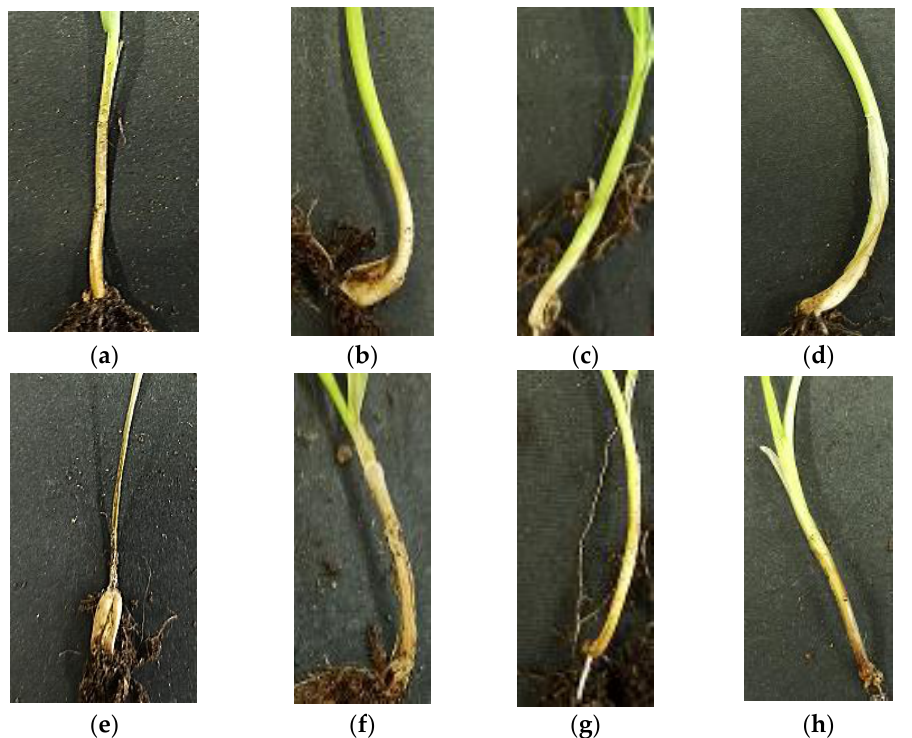
Figure 4. Effect of Trichoderma harzianum T-22 at 21 days after sowing, on the reduction in Fusarium crown rot symptoms in the seedling coleoptiles of four Italian tetraploid durum wheats derived from wheat seed treated with T-22 and sown in a substrate with F. culmorum ( a – d ) or left untreated ( e – h ): Ciclope ( a , e ), Creso ( b , f ), Simeto ( c , g ), and Saragolle Lucana ( d , h ).